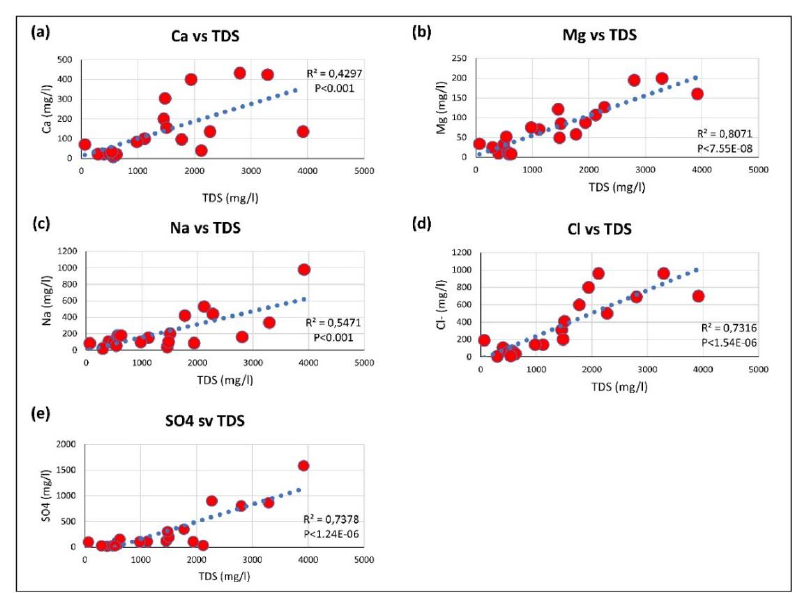
Figure 7. Cross plots of the major ions vs. Total Dissolved Solids (TDS) in the water samples used to determine the sources of the ions in water in Makueni County. ( a ) Cs vs. TDS; ( b ) Mg vs. TDS; ( c ) Na vs. TDS; ( d ) Cl vs. TDS; ( e ) SO 4 vs. TDS.